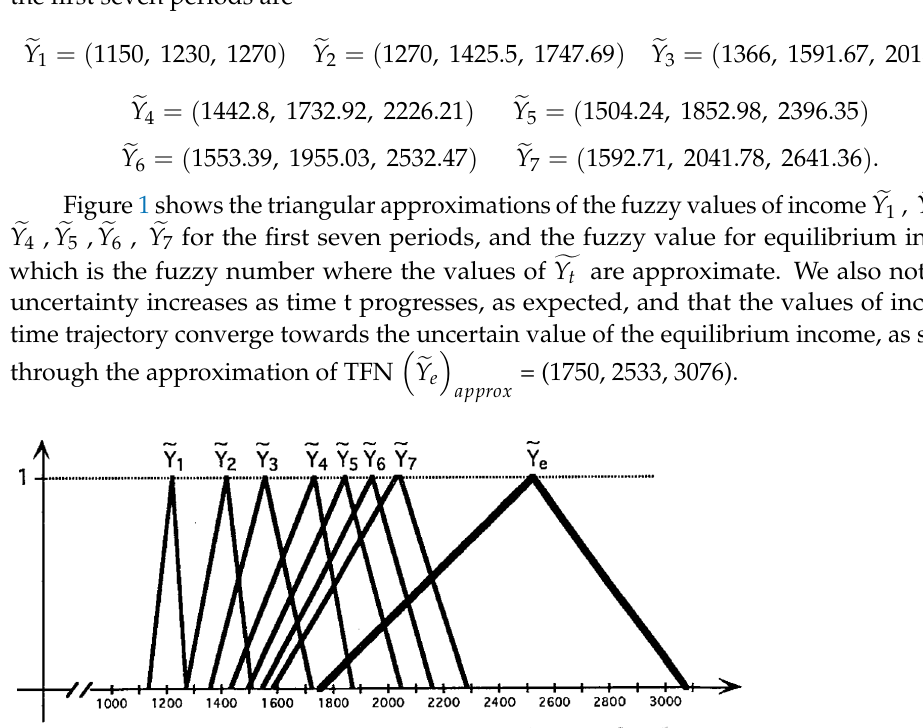
Figure 1. Fuzzy values for income in the first seven